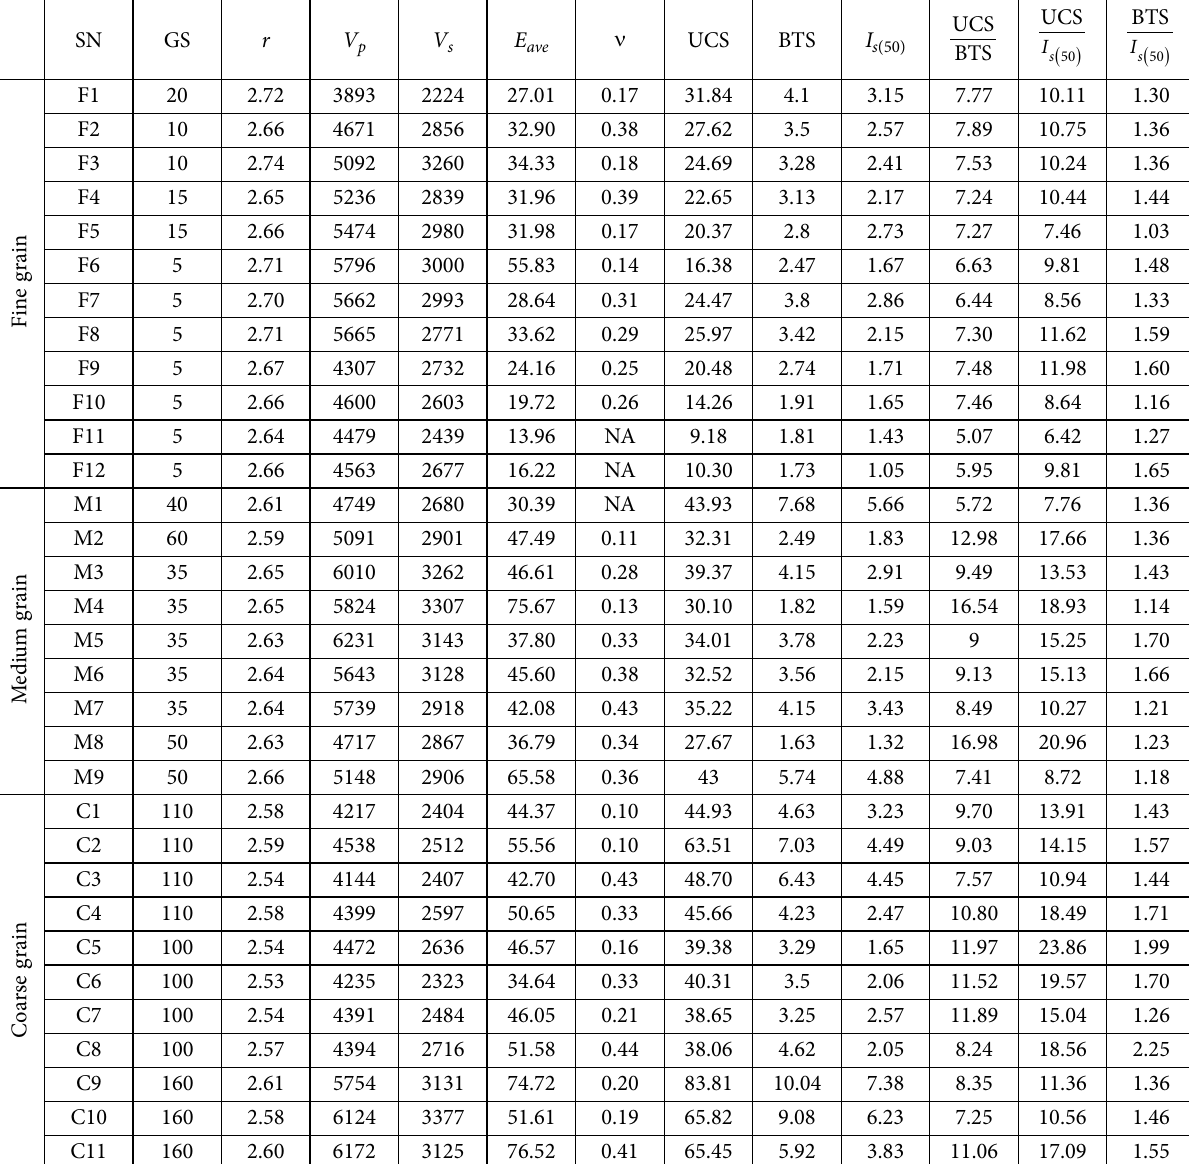
Table 2. Results of physical and mechanical tests conducted on dolomite